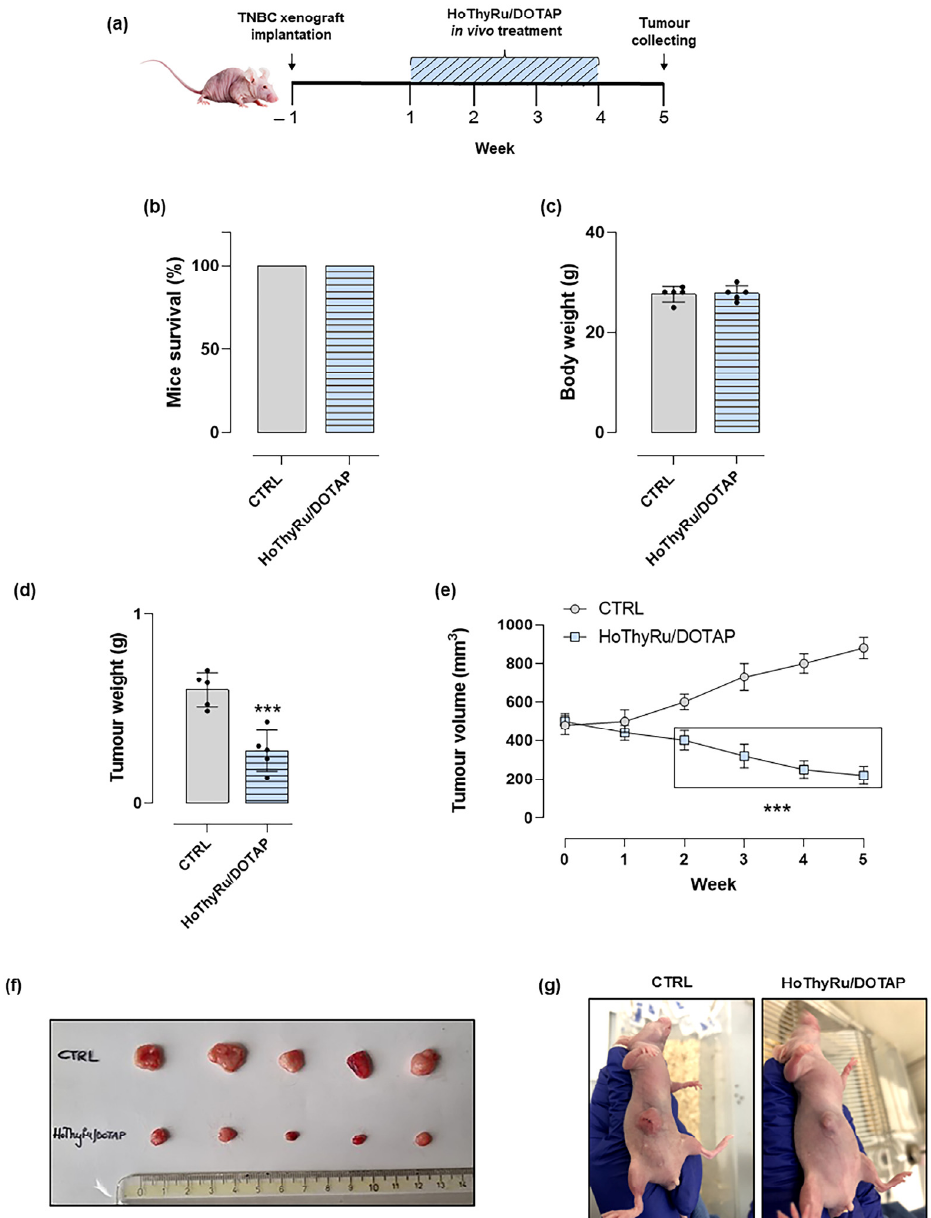
Figure 9. Animal biological responses to HoThyRu/DOTAP administration in vivo. ( a ) Experimental protocol and therapeutic scheme based on intraperitoneal (i.p.) administrations of HoThyRu/DOTAP (15 mg/kg) once a week for 28 days. ( b ) Overall mice survival and ( c ) body weights at the end of the study (5 weeks from the start of treatments). Control group (untreated xenotransplanted, n = 5 animals); xenotransplanted treated group (HoThyRu/DOTAP, n = 5 animals). ( d ) Weight analysis of the explanted tumor masses at the end of the study and ( e ) tumour volumes evaluation over time throughout in vivo experiments. Control group (untreated xenotransplanted, n = 5 animals); xenotransplanted treated group (HoThyRu/DOTAP, n = 5 animals). ( f ) Explanted tumor masses at the end point of the study from untreated (Control) and treated (HoThyRu/DOTAP) xenotransplanted animal groups. ( g ) Representative animal photographs at the end of the preclinical study relating to untreated xenotransplanted mice (Control) and treated xenotransplanted mice (HoThyRu/DOTAP) showing tumour inhibition by HoThyRu/DOTAP administration. Statistical analysis was conducted by one-way ANOVA followed by Bonferroni’s for multiple comparisons. *** p < 0.001 vs. control animal